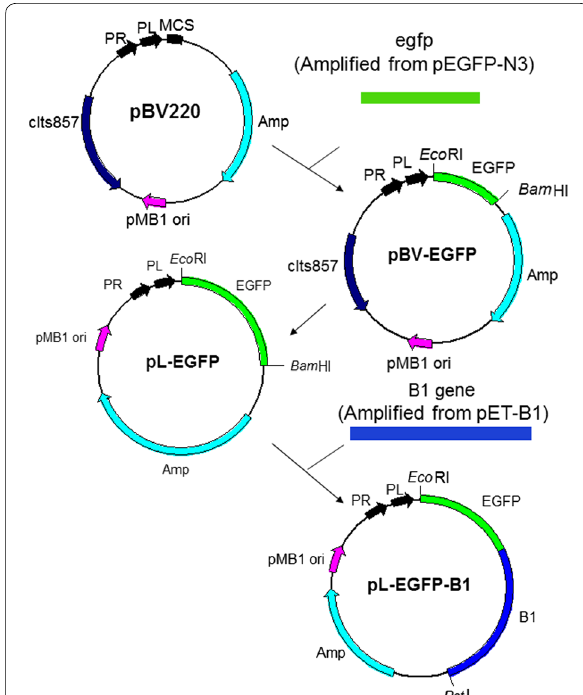
Fig. 1 Construction map of the recombinant plasmid. Construction map of the plasmid pL‑EGFP‑B1. The egfp gene without the stop codon was cloned into the plasmid pBV220 to construct the plasmid pBV‑EGFP. The entire sequence of pBV‑EGFP except the cIts857 gene was amplified by PCR and self‑circularized to generate the plasmid pL‑EGFP. Then, the B1 gene was inserted to generate the final